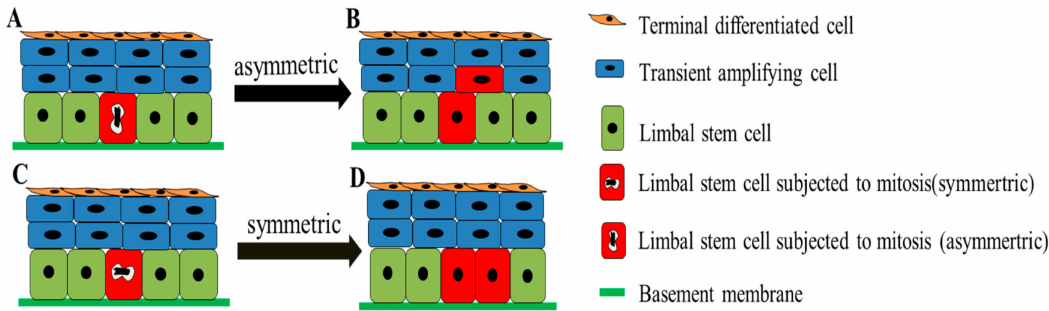
Figure 3. Simplified model of symmetric and asymmetric division of LSCs. When the LSC (red) undergoes mitosis, it can be subjected to asymmetric division ( A ) to divide into a stem cell remaining anchored on the BM and a daughter cell detaches from the BM and migrates forward to be a TAC ( B ), or to asymmetric division ( C ) to divide into two similar daughter stem cells both remaining anchored on the BM ( D ).